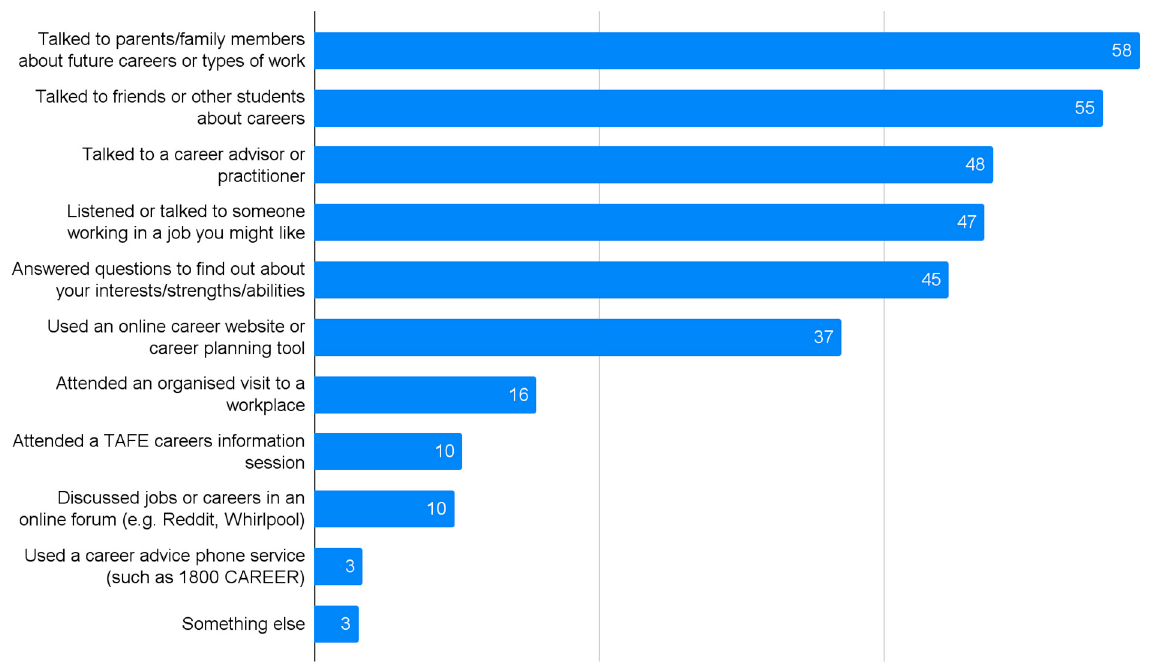
Figure 1. Which of the following activities have you ever done to help make decisions about your future career? (Data source: Survey. n = 1046 [excludes 62 (6%) respondents who selected ‘none of the above’]).